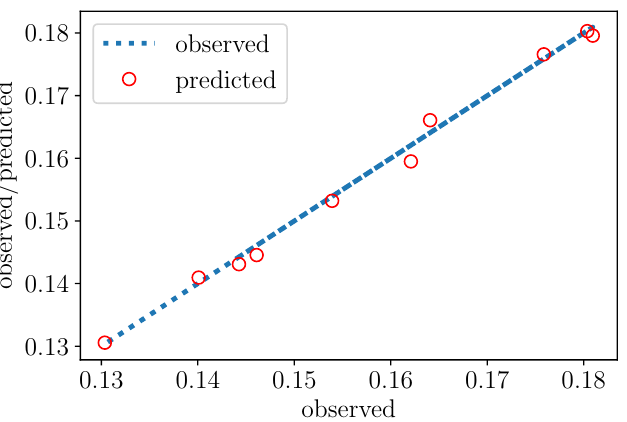
Figure 7. The observed/predicted validation plot showing the norm of the observed (test data) and the corresponding model